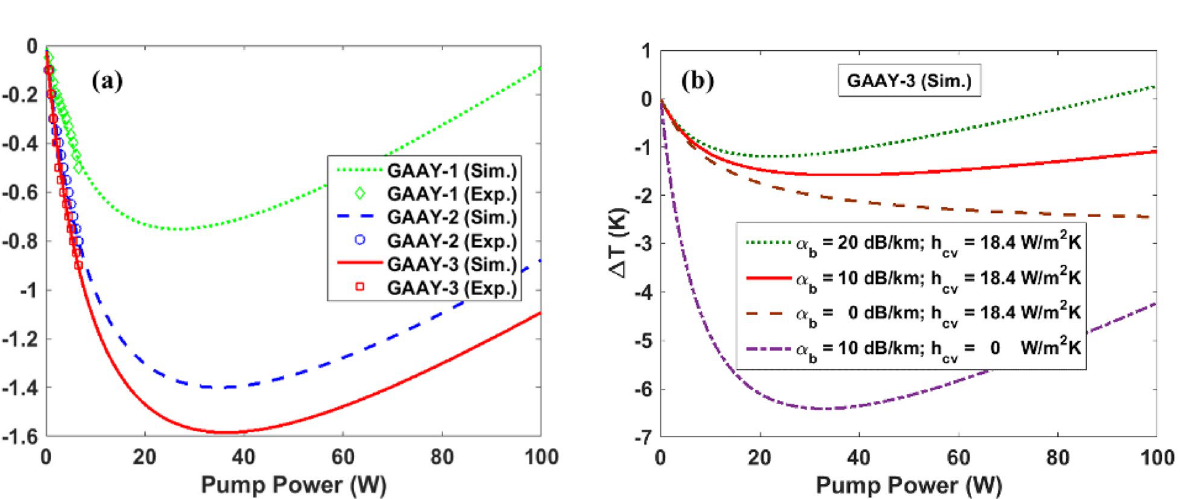
Figure 5. ( a )The temperature change as a function of the pump power in GAYY glasses in air. The markers show the experimental results for the pump powers up to 6.5 W, ( b ) The effect of background absorption and convective heat load in obtaining temperature reduction with a change in pump power in GAYY-3